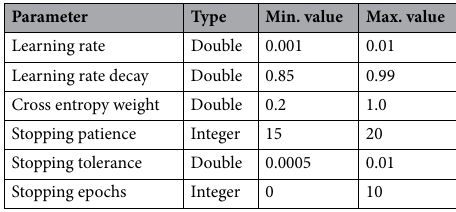
Table 3. Input values for hyper-parameter